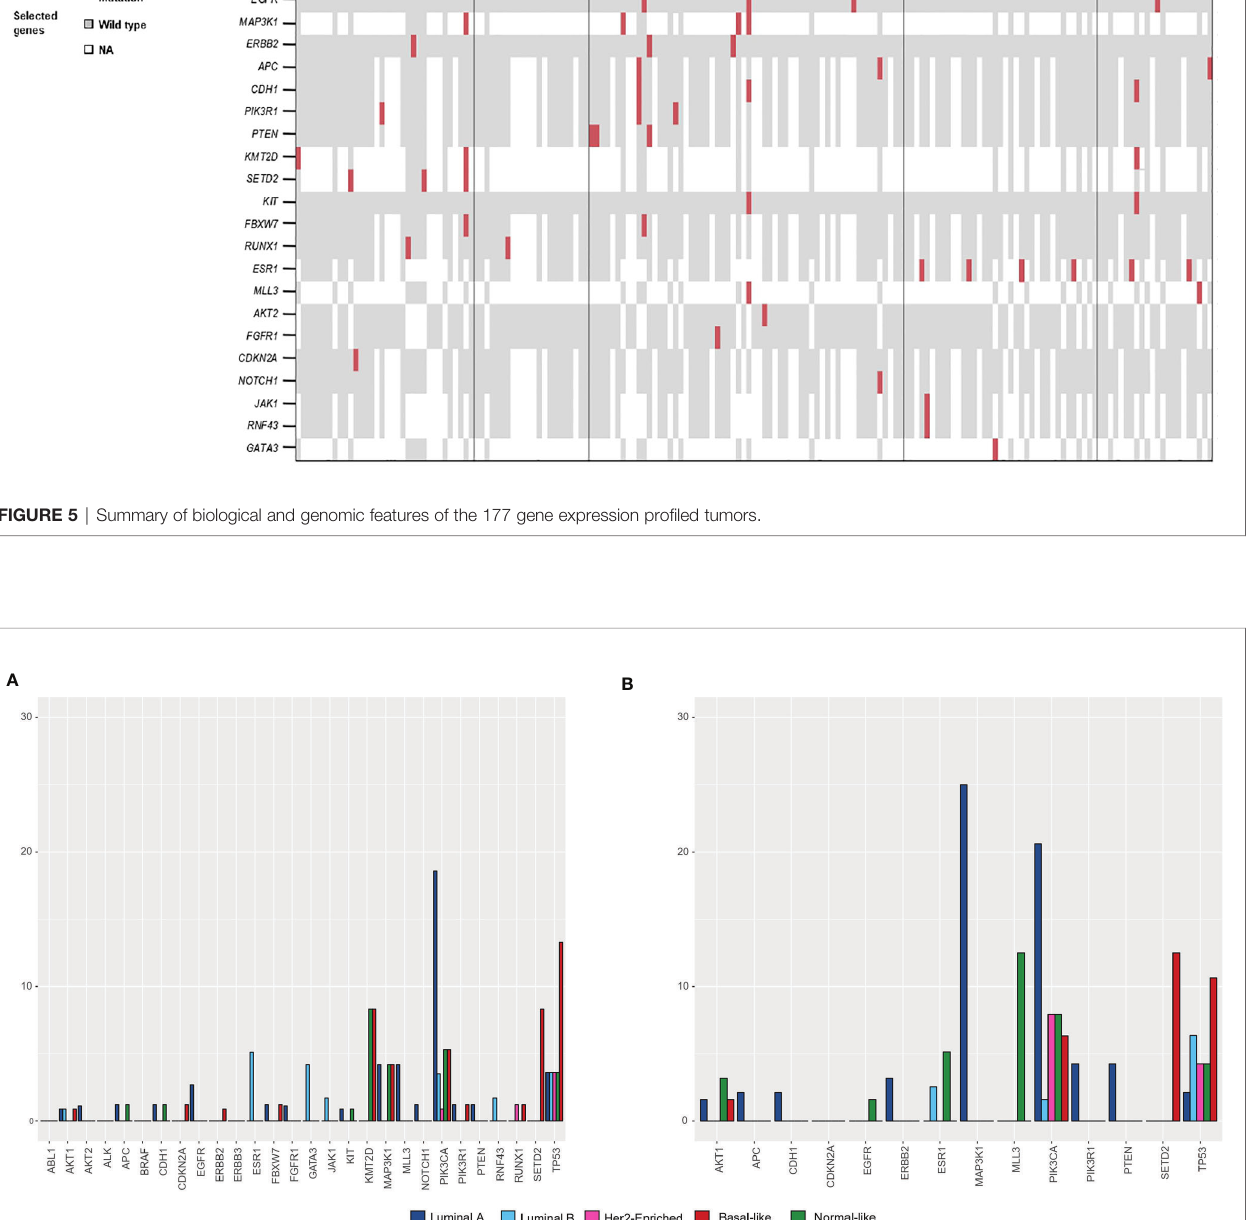
FIGURE 6 | Percentage of patients with genomic alterations based on the PAM50 intrinsic subtype in (A) primary tumors (n = 114), (B) in metastatic tumors (n =